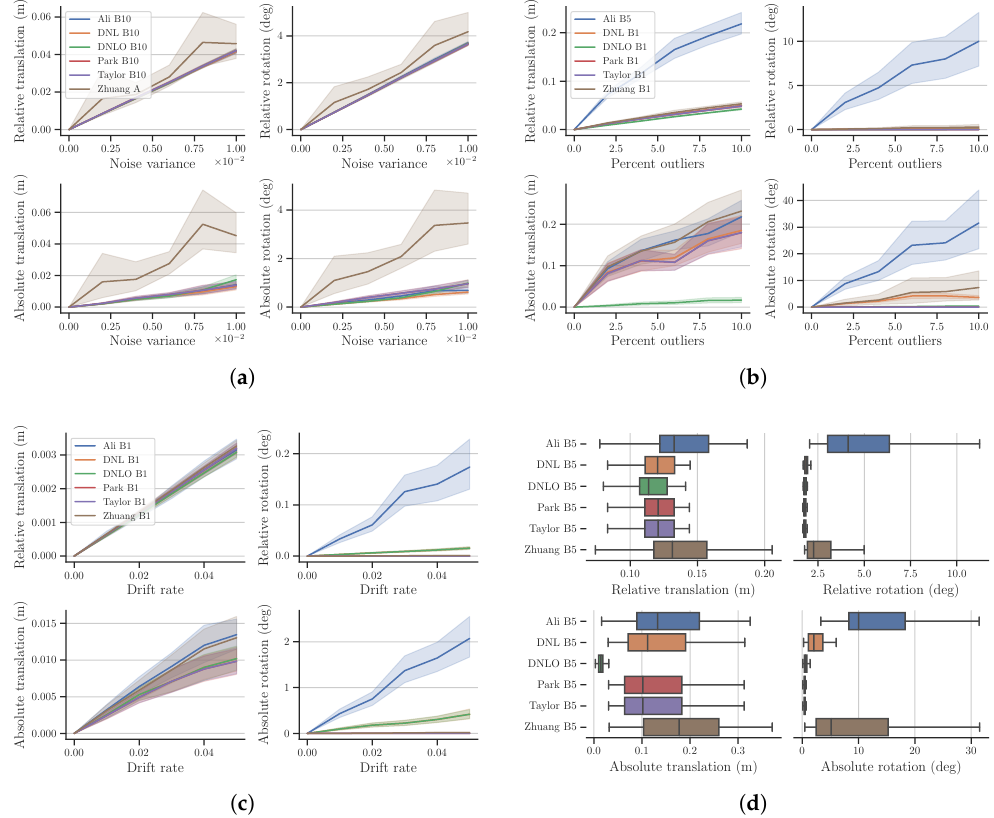
Figure 5. Calibration errors on simulation data for best performing variant of each algorithm: ( a ) added Gaussian noise, ( b ) added outliers, ( c ) added drift, and ( d ) mixed noise. Plots ( a ) through ( c ) display the mean and 95% confidence intervals, whereas the boxplot ( d ) shows the median and